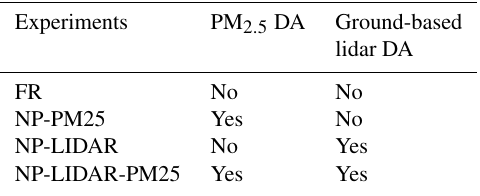
Table 1. Summary of the experimental design in this